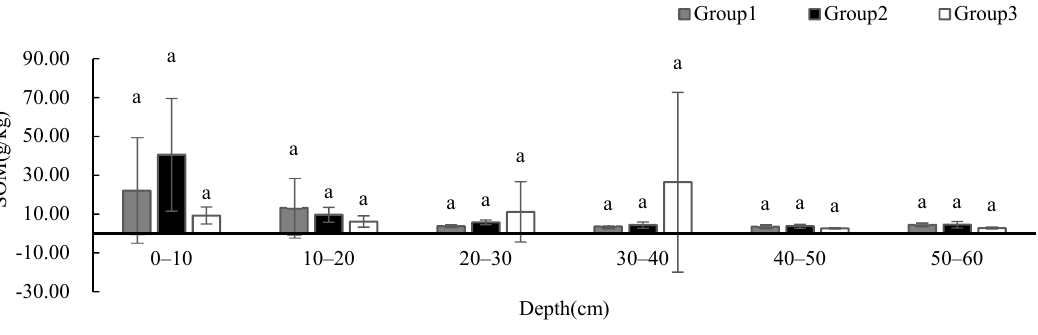
Figure 8. One-way ANOVA results of soil pH under different vegetation cover types at different depths ( p < 0.05).